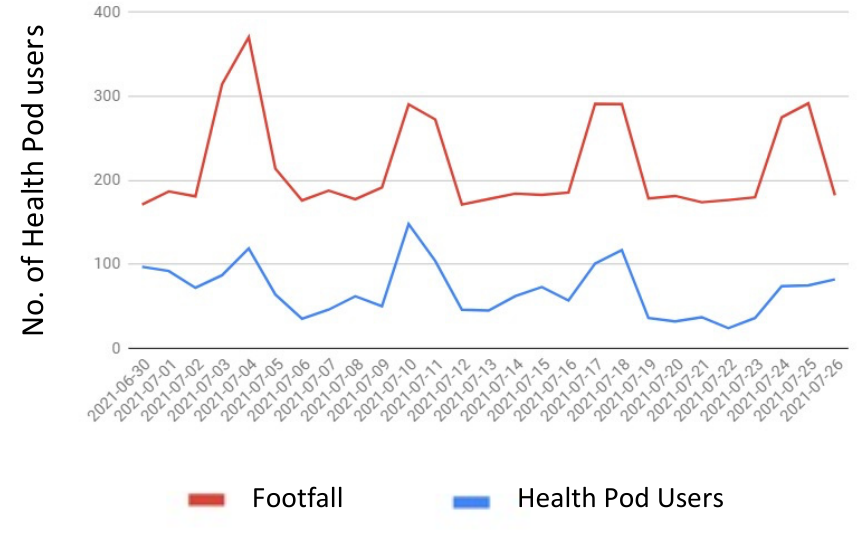
Figure 4. Health pod recruitment in tests in respect to total footfall at S1.